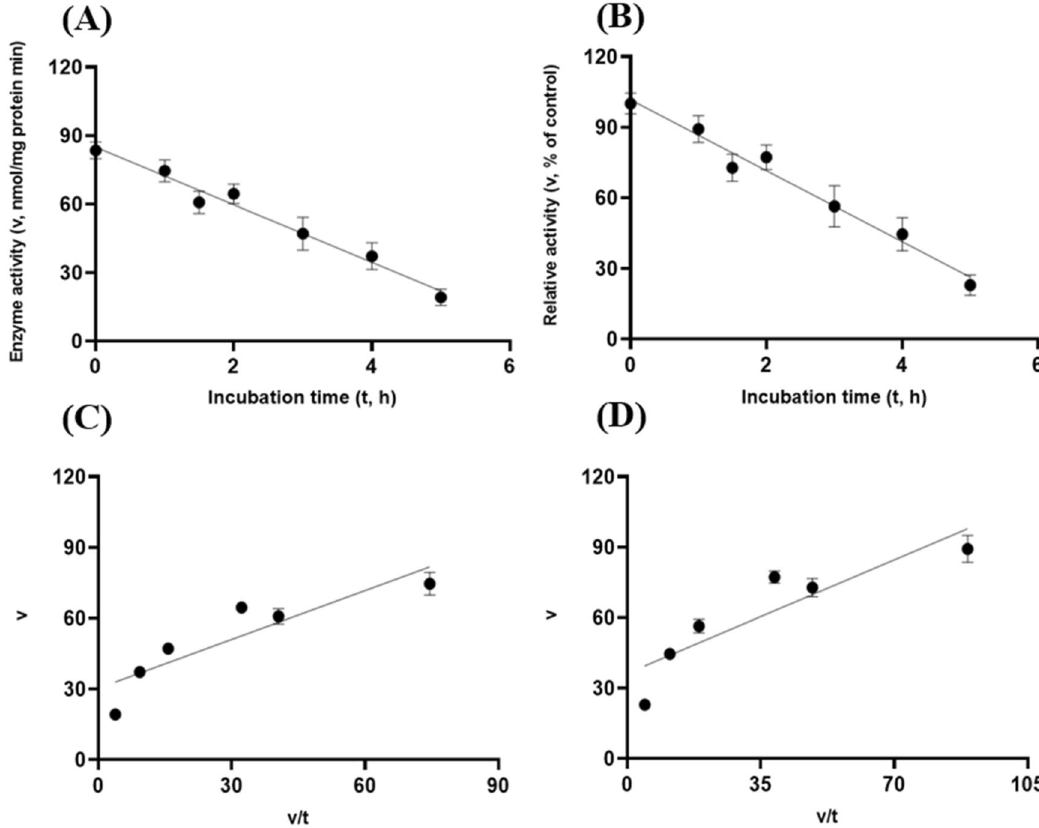
Figure 11. Experiment-2 of the gastric acidic pH and pepsin (274 U/mL) effects (with describing model parameter estimates ± SE ) on GH5-p4818Cel5_2A activity over a 5-h period after the gastric pH and pepsin buffer being mixed with the GH5-p4818Cel5_2A enzyme preparation for incubation at the resulting mixture pH = 3.5 and pepsin at 274 U/mL prior to further incubation for measuring cellulase activity with the carboxymethyl cellulose (CMC) substrate buffer in presence of dithiothreitol (DTT) (5 mM) and N 2 gas purging for 15 min at 37 °C. (A) Linear plot of the inhibition kinetic relationship between the GH5-p4818Cel5_2A activity (v, mean ± SE, n = 12at each time point, nmol/mg protein•min) and incubation time (t, h) under the gastric pH 3.5 and pepsin (274 U/mL) conditions established according to the linear response model as: y = 85.348 ( ± 3.415 ) − 12.702 ( ± 1.187 ) x , P < 0.0001 for all parameter estimates; r 2 = 0.606 , n = 84; and alternatively, according to the exponential response model established as Y = 89.186 ( ± 4.359 ) e [− 0.227 ( ± 0.026 ) x ] , P < 0.0001 all parameter estimates; R 2 = 0.581 , n = 84; (B) Linear plot of the inhibition kinetic relationship between the relationship of relative GH5-p4818Cel5_2A activity (v, mean ± SE, n = 12at each time point, % of the control group measured at I C of 100.000 ± 4.416) at the 0-min exposure to the gastric pH-3.5 and pepsin-274 U/mL incubation) and incubation time under gastric pH 3.5 and pepsin (274 U/mL) conditions according to the linear response model established as: y = 102.1 ( ± 4.088 ) − 15.202 ( ± 1.421 ) x , P < 0.0001 for all parameter estimates, r 2 = 0.606 , n = 84; and established according to the exponential response model as Y = 106.7 ( ± 5.218 ) e [− 0.227 ( ± 0.026 ) x ] , P < 0.0001 all parameter estimates, R 2 = 0.581 , n = 84; (C ) the Eadie- Hofstee linear plot between the GH5-p4818Cel5_2A enzyme activity (v, mean ± SE, n = 12at each data point, nmol/mg protein•min) and the v/t ratio established as y = 26.418 ( ± 2.663 ) + 0.829 ( ± 0.069 ) x , P < 0.0001 for all parameter estimates, r 2 = 0.677 , n = 72; and (D ) the Eadie-Hofstee linear plot between the relative GH5- p4818Cel5_2A enzyme activity (v, mean ± SE, n = 12at each data point, % of the control group measured at I C of 100.000 ± 4.416) at the 0-min exposure to the gastric pH-3.5 and pepsin-274 U/mL incubation) and the v/t ratio established as y = 31.618 ( ± 3.187 ) + 0.829 ( ± 0.070 ) x , P < 0.0001 for all parameter estimates, r 2 = 0.677 , n =